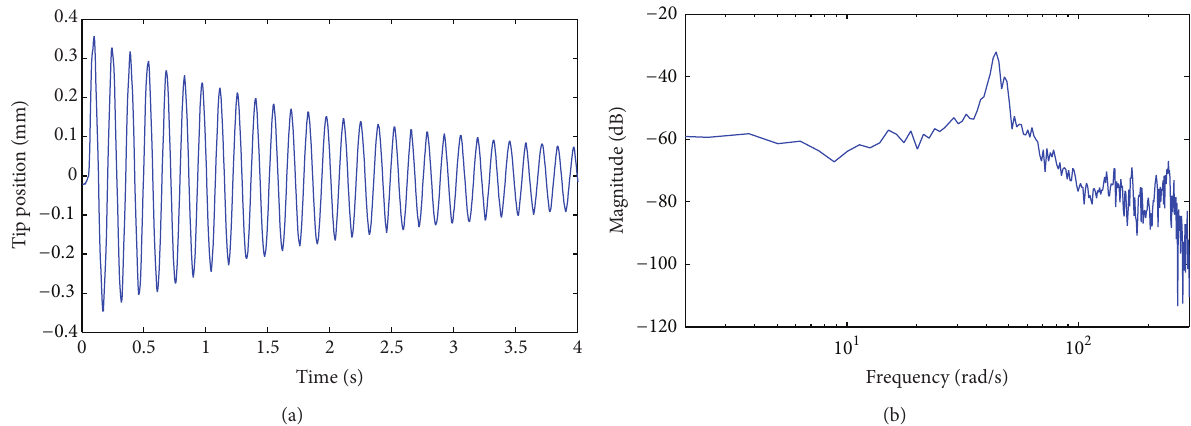
Figure 3: Experimental system’s responses: (a) pulse response, (b) frequency response function.